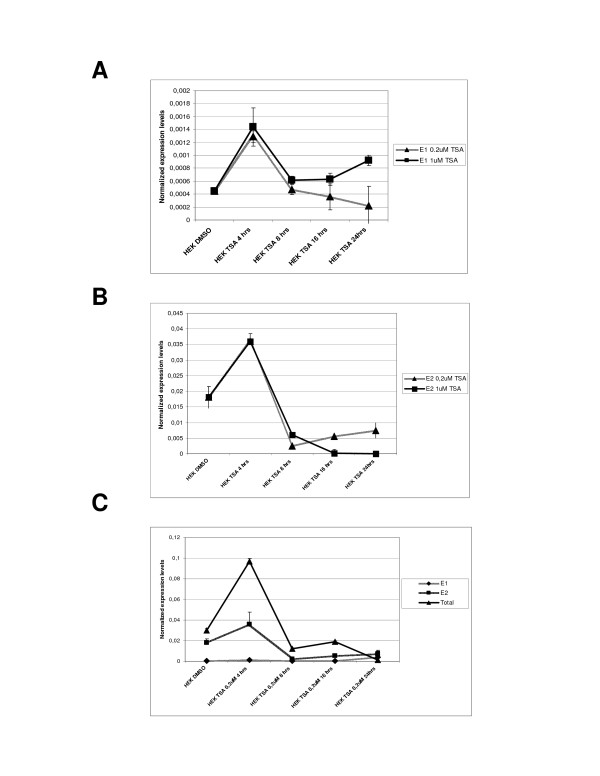
Endogenous BCL2L11(BIM) transcripts comprising E1, E2 and 3'coding sequences are coordinately regulated by TSA in HEK293 cells. For simplicity the alias BIM is used in the figure instead of the approved gene symbol BCL2L11. A. Time course of expression of Exon 1-containing BIM transcripts in HEK293 cells following TSA treatment as measured by real-time PCR, using an E1-specific primer set (E1); TSA rapidly induces BIM-E1 expression at 4 hrs at both concentrations tested. B. The same analysis was performed using primer sets specific for the (previously known) BIM Exon 2; The expression of the P2-derived BIM transcript in HEK293 cells (E2) is induced by TSA at 4 hrs at the concentrations of 0.2 μM (i) and 1 μM (ii), as for E1 containing BIM transcripts. C. Time course of expression of BIM transcript levels in HEK293 cells treated with 0.2 μM TSA, and detected using primers specific for a 3' region of the coding sequence (and presumably recognizing most BIM transcripts; Total) or primers specific for Exon 1- or Exon 2-bearing BIM transcripts (E1 or E2, respectively).